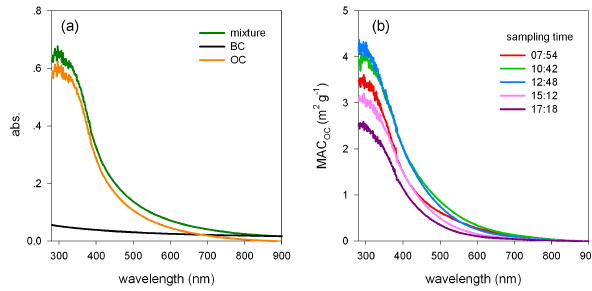
Fig. 1. (a) The decoupled absorbance spectrum of wood smoke OC obtained by subtracting the BC absorbance from the total ab- sorbance of wood-burning particles. (b) The diurnal pattern of MAC OC of wood smoke OC photochemically aged under natural sunlight (11 October 2012, medium NO x )